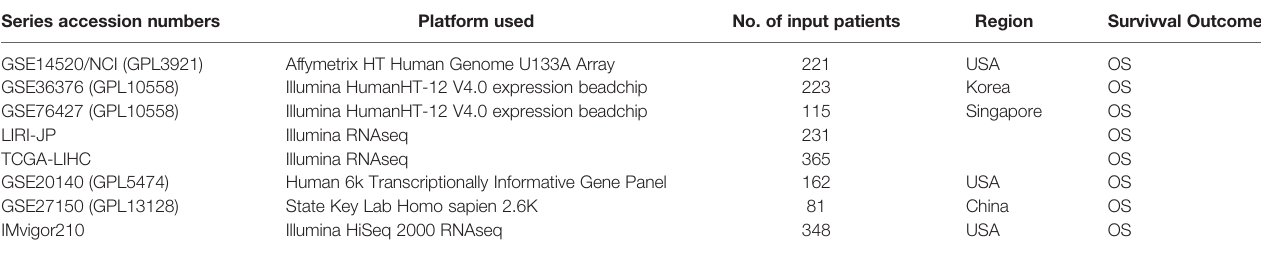
TABLE 1 | Basic information of datasets included in this study for identifying distinct